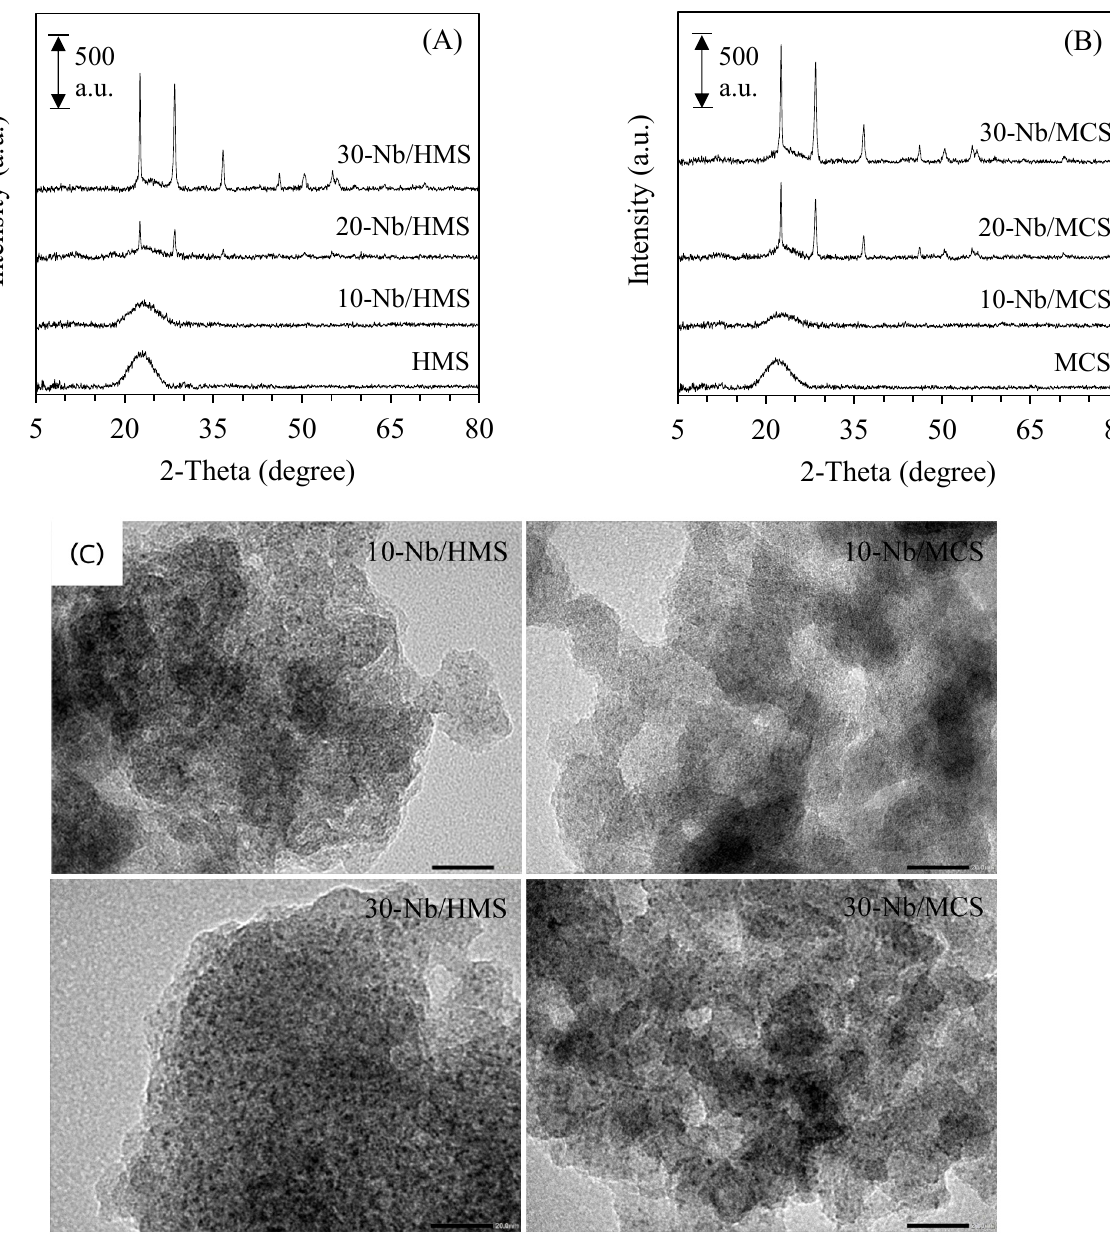
Figure 2. ( A , B ) XRD patterns of ( A ) X -Nb/HMS and ( B ) X -Nb/MCS catalysts, and ( C ) TEM images of representative X -Nb/HMS and X -Nb/MCS catalysts at magnification of 400,000×.